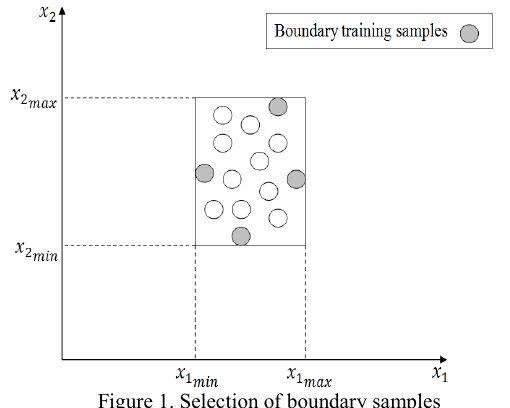
Figure 1. Selection of boundary samples